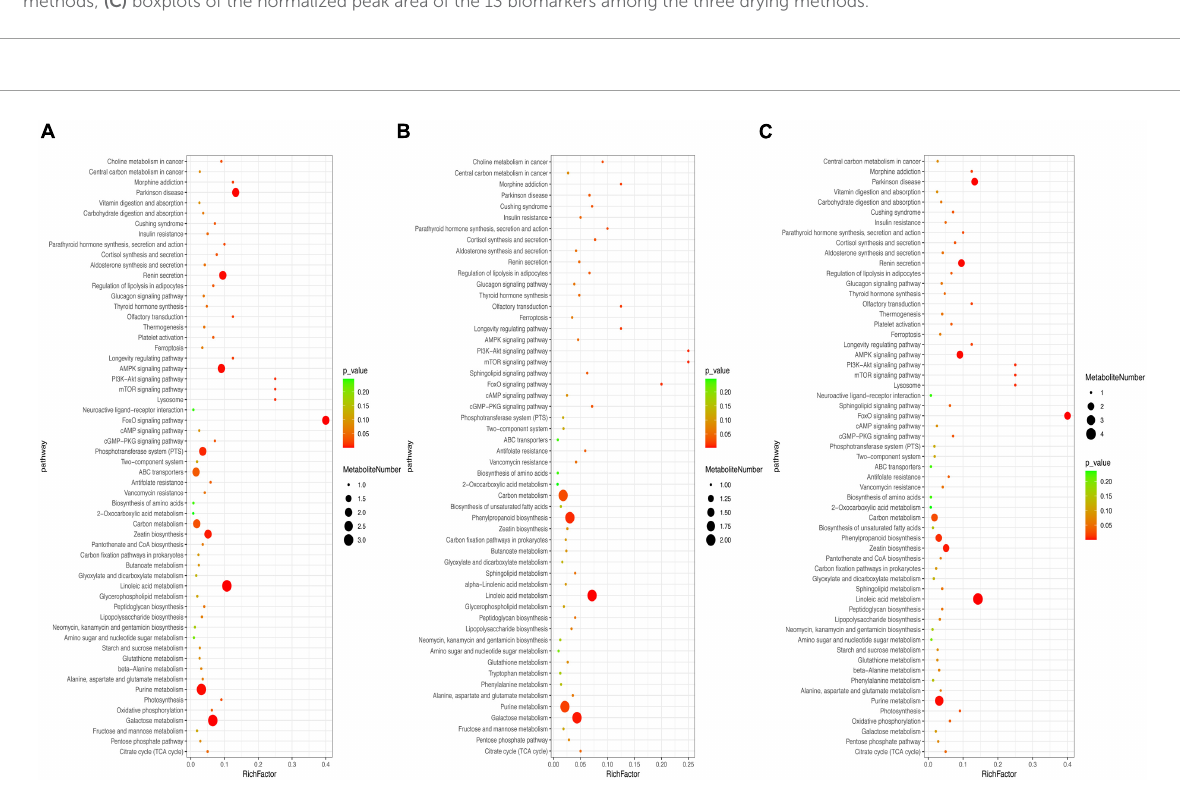
FIGURE5 Metabolomic enrichment pathway analysis: (A) CD vs. ED, (B) CD vs. FD, (C) ED vs.